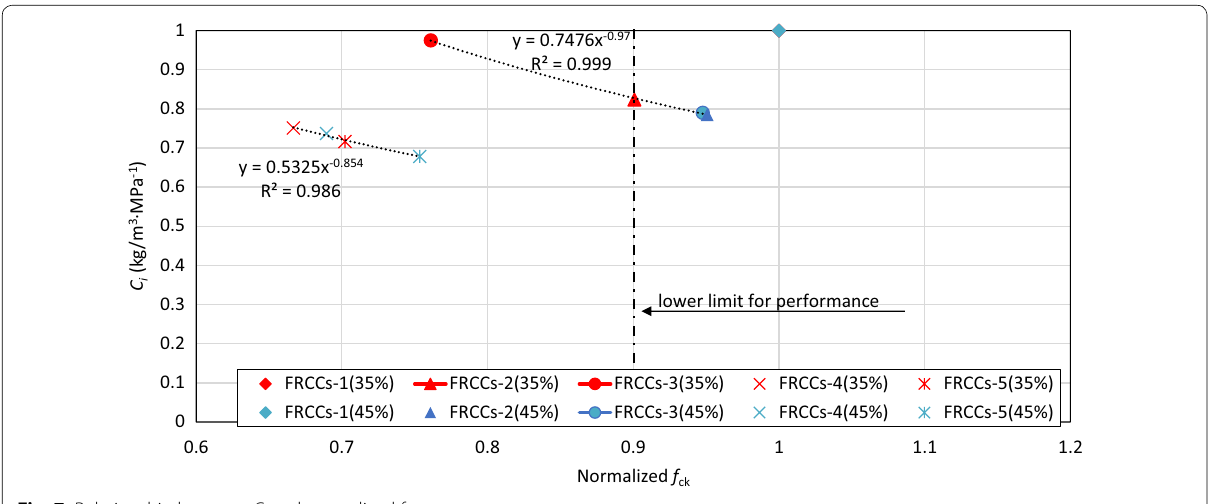
Fig. 7 Relationship between C i and normalized f ck